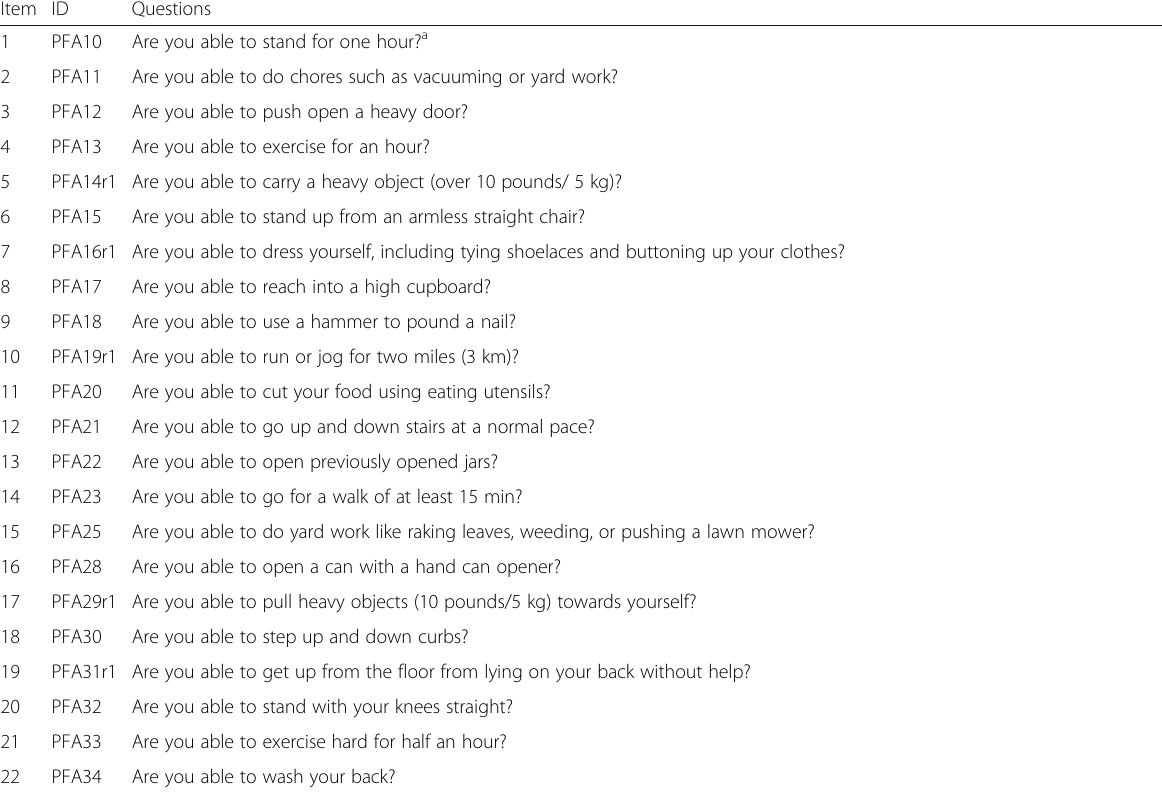
Table 5 PROMIS v1.2 Physical Function item